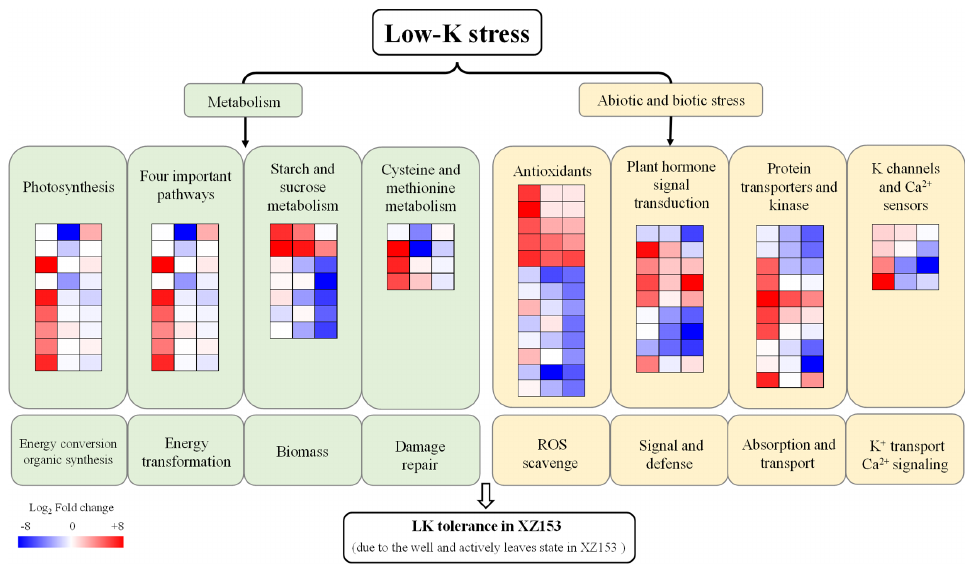
Figure 8. A hypothetical model of LK tolerance mechanism underlying in XZ153. Genes are shown by different colors and relative expression levels are shown by a color gradient from low (blue) to high (red). For each heatmap, from left to right: XZ153 (first column), XZ141 (second column), ZD9 (third